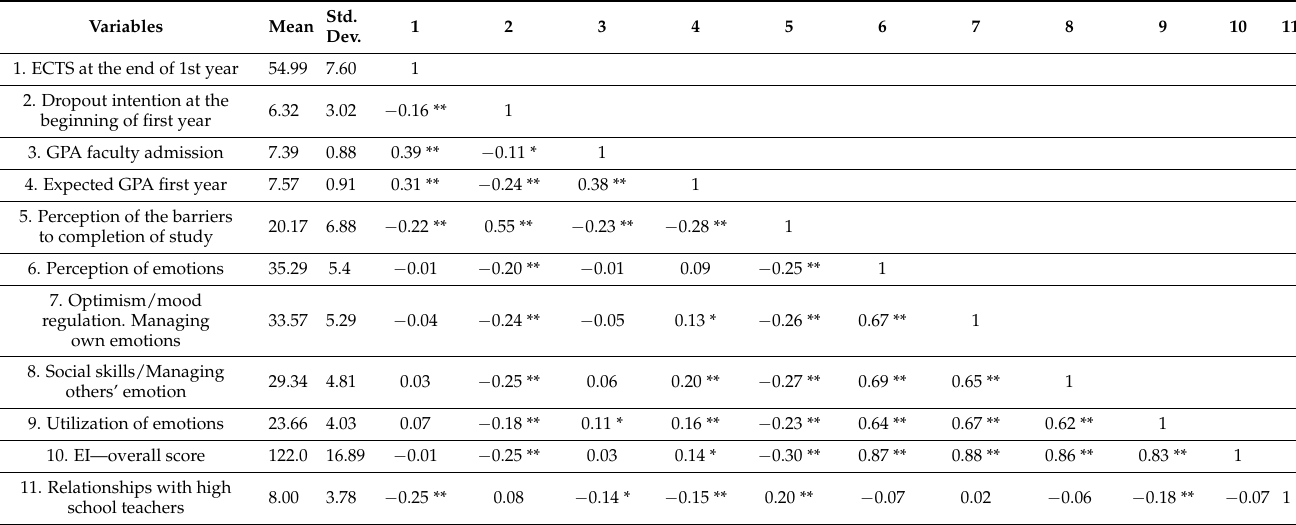
Table 1. Descriptive statistics and zero-order correlations (H1.1 and H1.2).